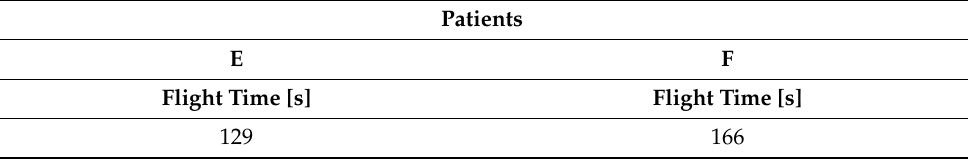
Table 6. Results of the patients’ flight times in the principal indoor experiment.